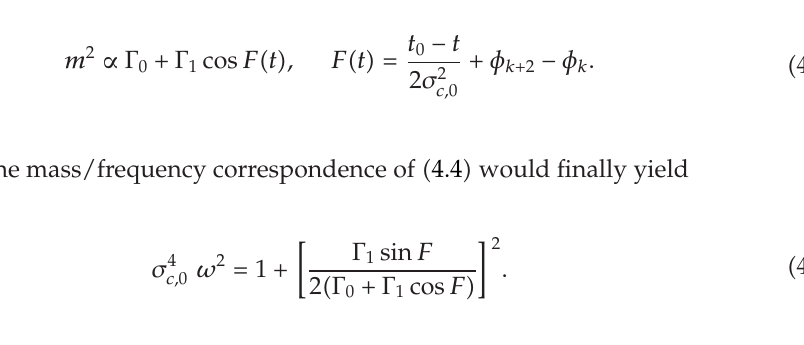
Figure 8: Wigner functions of (cid:4) 1 /